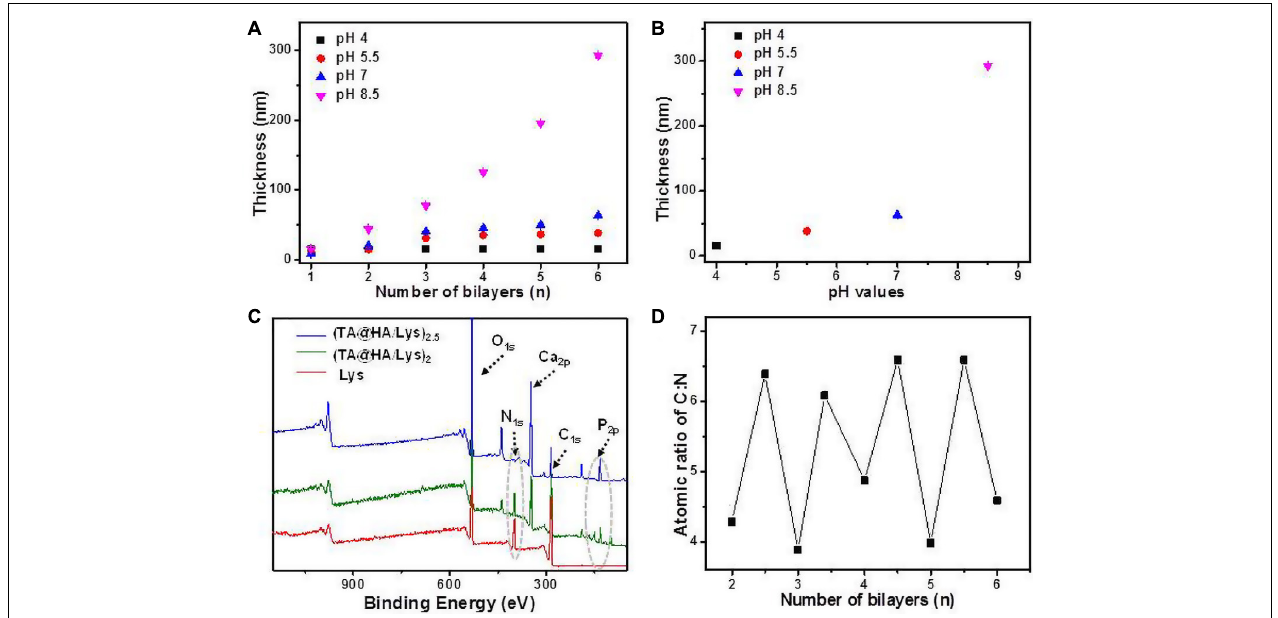
FIGURE 2 | (A) The thickness of (TA@HA/Lys) n - pH deposited at various pH values plotted as the function of a number of bilayers. (B) The thickness of (TA@HA/Lys) 6 - pH constructed at different pHs. (C) XPS spectra of lysozyme (Lys), (TA@HA/Lys) 2 − 8 . 5 , and (TA@HA/Lys) 2 . 5 − 8 . 5 . (D) Elemental content ratio of C:N in (TA@HA/Lys) n - 8 . 5 as the function of a number of bilayers. The line in all figures was used for eye